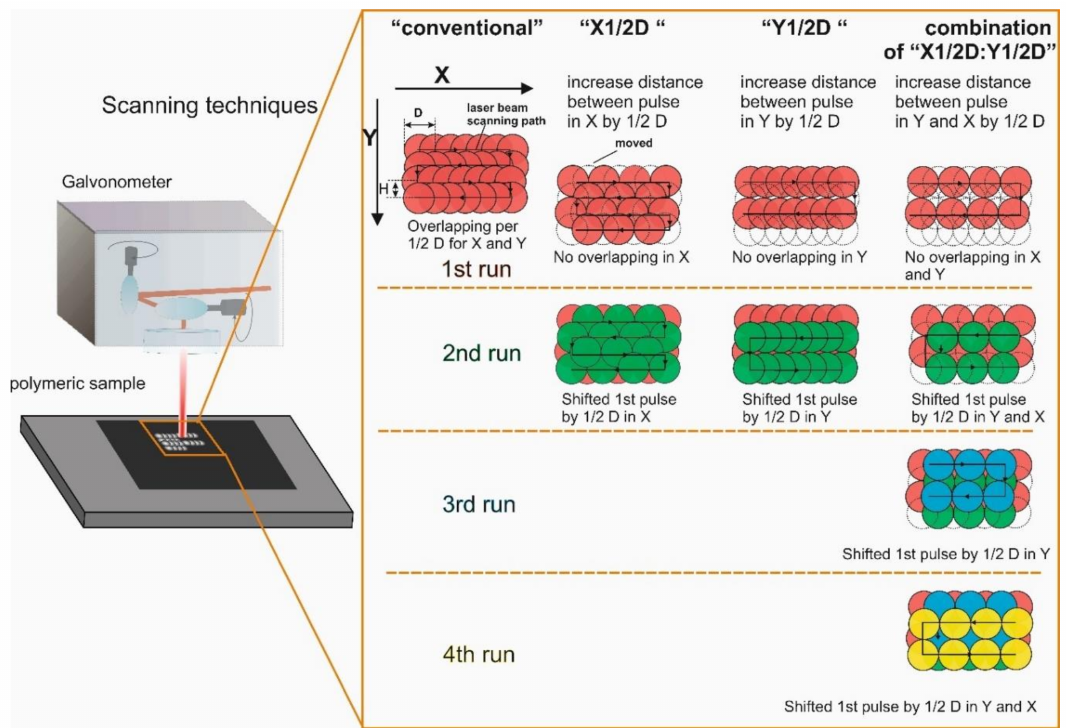
Figure 2. Laser writing techniques using a galvanometer scanner. D is the diameter of the laser pulse, and H is the hatch (the distance between laser-written lines). The 1st, 2nd, 3rd and 4th runs refer to the number of laser scans over the area. Arrows in the figure indicate the scanning direction. The X-axis is the direction of laser